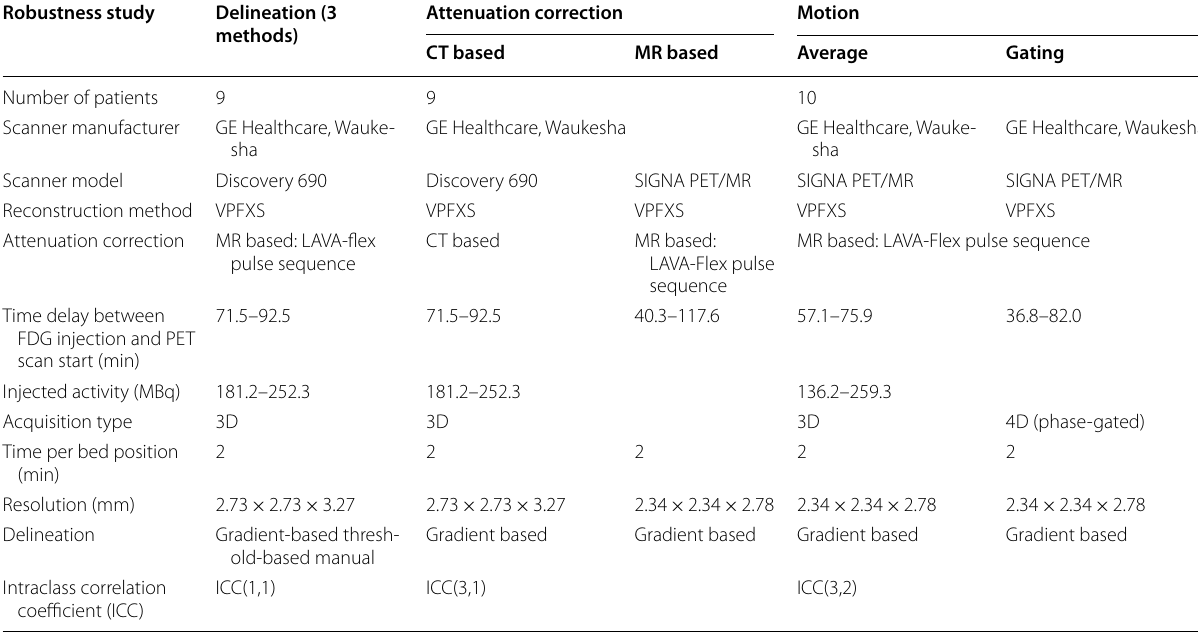
PET image dataset acquisition characteristics including reconstruction and delineation protocols for the three datasets are